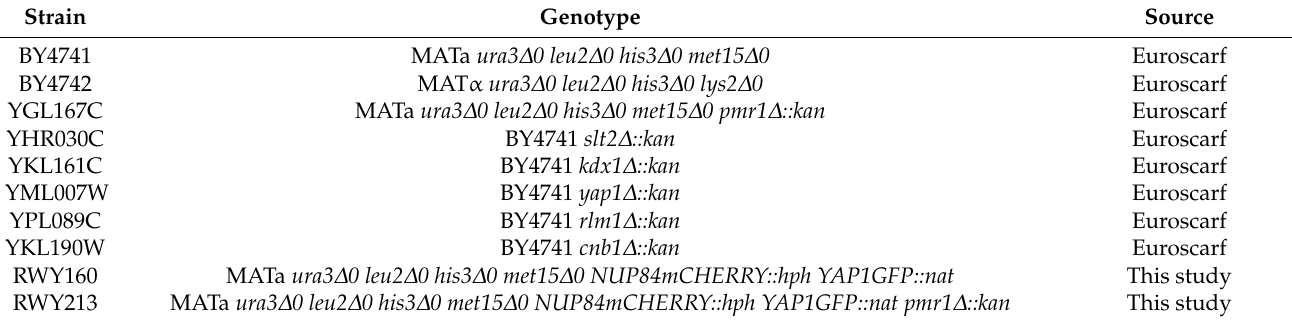
Table 1. Yeast strains used in this